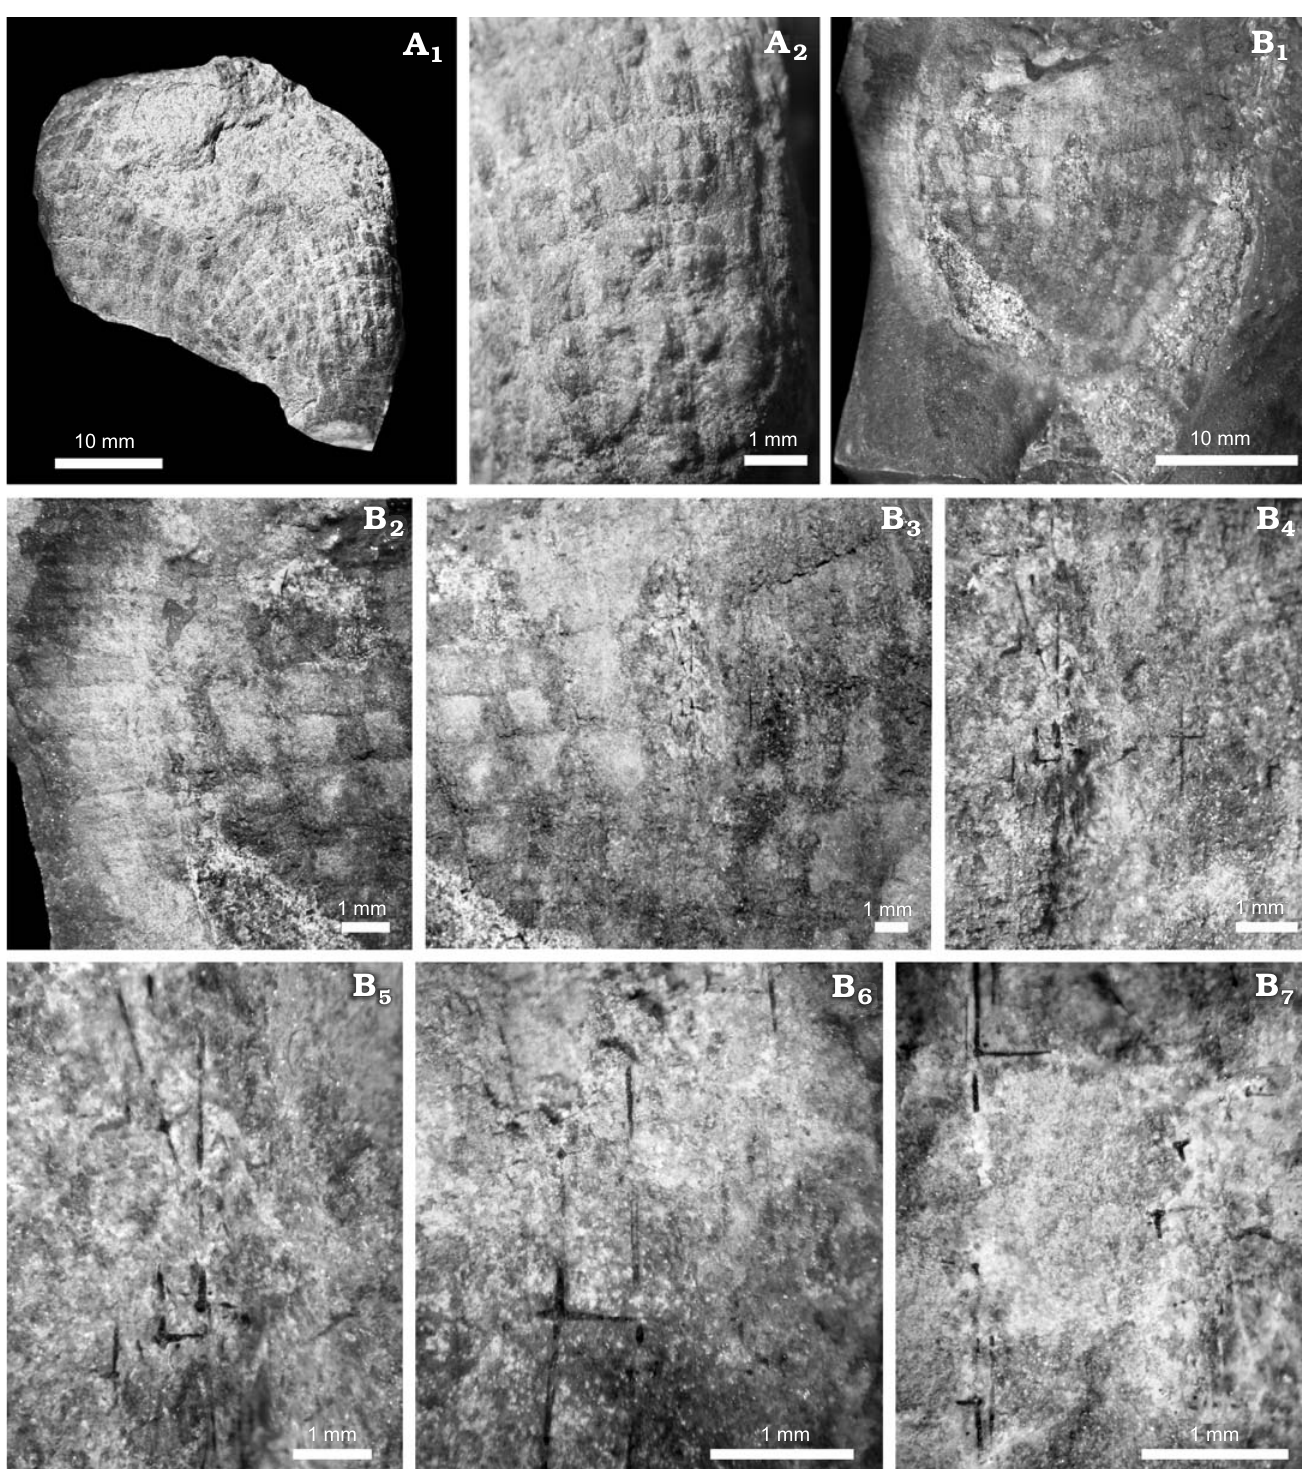
Fig. 2. Hexactinellid sponge Minitaspongia parvis gen. et sp. nov. from the Tournaisian Carboniferous, Sierra de las Minitas section, La Rioja Province, Argentina. A . Holotype PULR-I 4, complete obconical specimen, showing the cylindrical acute base. External surface of the holotype showing deep im- pressions of vertical and horizontal tracts and cross-shaped spicule molds as second order elements in the middle of first order quadrules (A 2 ). B . Paratype PULR-I 5, external impression with original spicules forming the reticulate skeleton (B 1 ); detail showing a well preserved external area of the second order quadrules (B 2 ); detail of the first order quadrules showing preserved hexactine-based spicules aligned (B 3 ); detail of the tract with vertically ori- ented, main long axis hexactine- based spicules, bundles of two or three long spicule axis occur in the tract (B 4 ); enlarged section of B 4 showing nodes of the perpendicular axis of the hexactins (B 5 ); details of the spicules in the tracts, long rayed hexactins, and small second order hexactins with equal-ray dimensions (B 6 , B 7